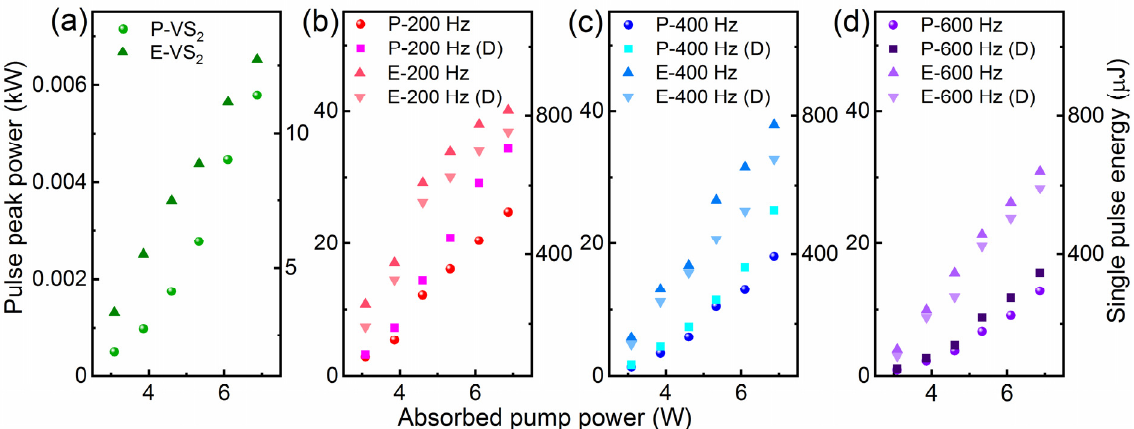
Figure 7. Relationship between absorbed pulse peak power, single pulse energy, and pump power of (a) VS 2 Q-switched laser, (b) actively and doubly Q-switched lasers at 200 Hz, (c) actively and doubly Q-switched lasers at 400 Hz, (d) actively and doubly Q-switched lasers at 600 Hz. P—peak power; E—pulse energy.